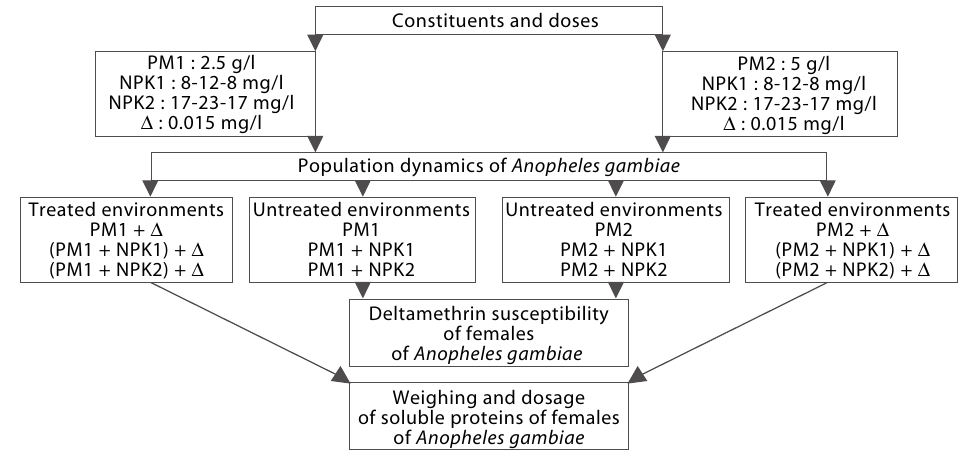
Fig. 1. – Quantities of plant matter (PM), NPK fertilizer and delta- methrin ( Δ ) included in the combination of the environments evaluated on Anopheles gambiae VKPR and KIS strains. An. gambiae females from untreated environ- ments were submitted to susceptibility tests using deltamethrin while those emerging from treated environments were wei- ghed and analyzed to determine their soluble protein